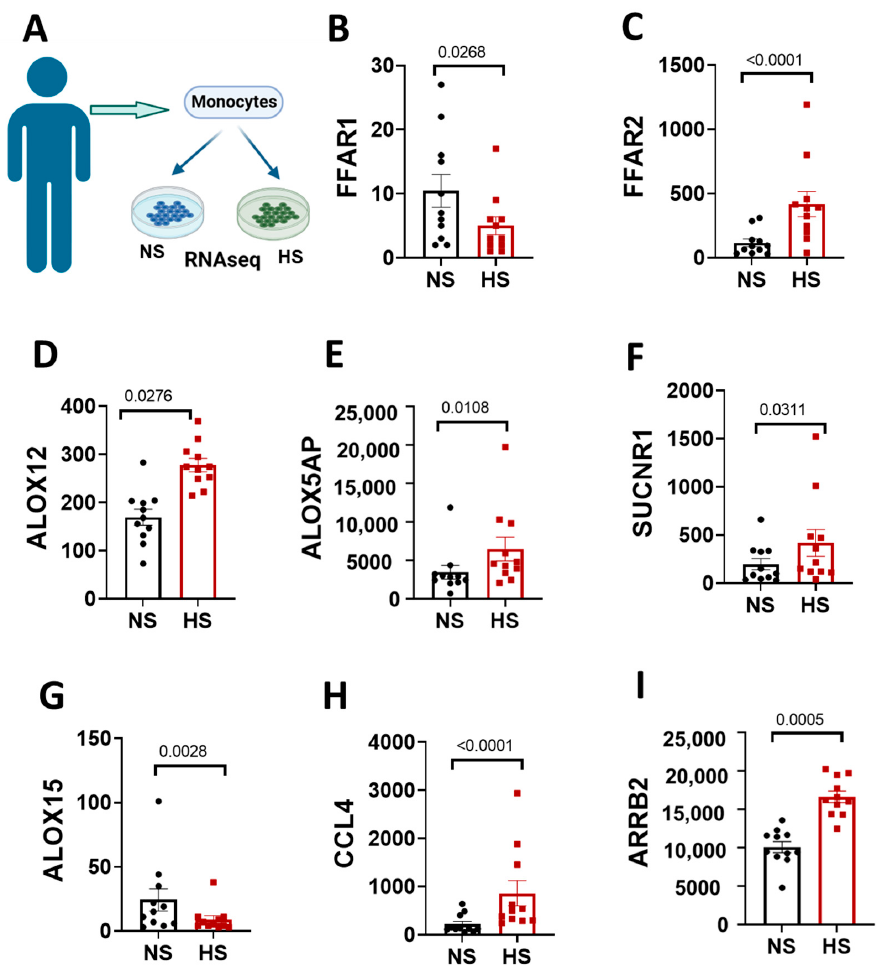
Figure 6. EffectofsaltonhumanmonocyteRNAtranscriptome. ( A )Humanmonocyteswereisolatedfrom 11 subjects and treated with normal salt (150 mM NaCl) or high salt (190 mM NaCl) in vitro. ( B ) FFAR1, ( C ) FFAR2, ( D ) ALOX12, ( E ) ALOX5AP, ( F ) SUCNR1, ( G ) ALOX15, ( H ) CCL4 and ( I ) ARRB2 show RPKM for selected receptors and chemokines. Adjusted p -values (q) are shown in ( E , F ) using a false discovery rate (FDR < 0.05). p -values were determined using 2-tailed unpaired Student’s t tests, n =